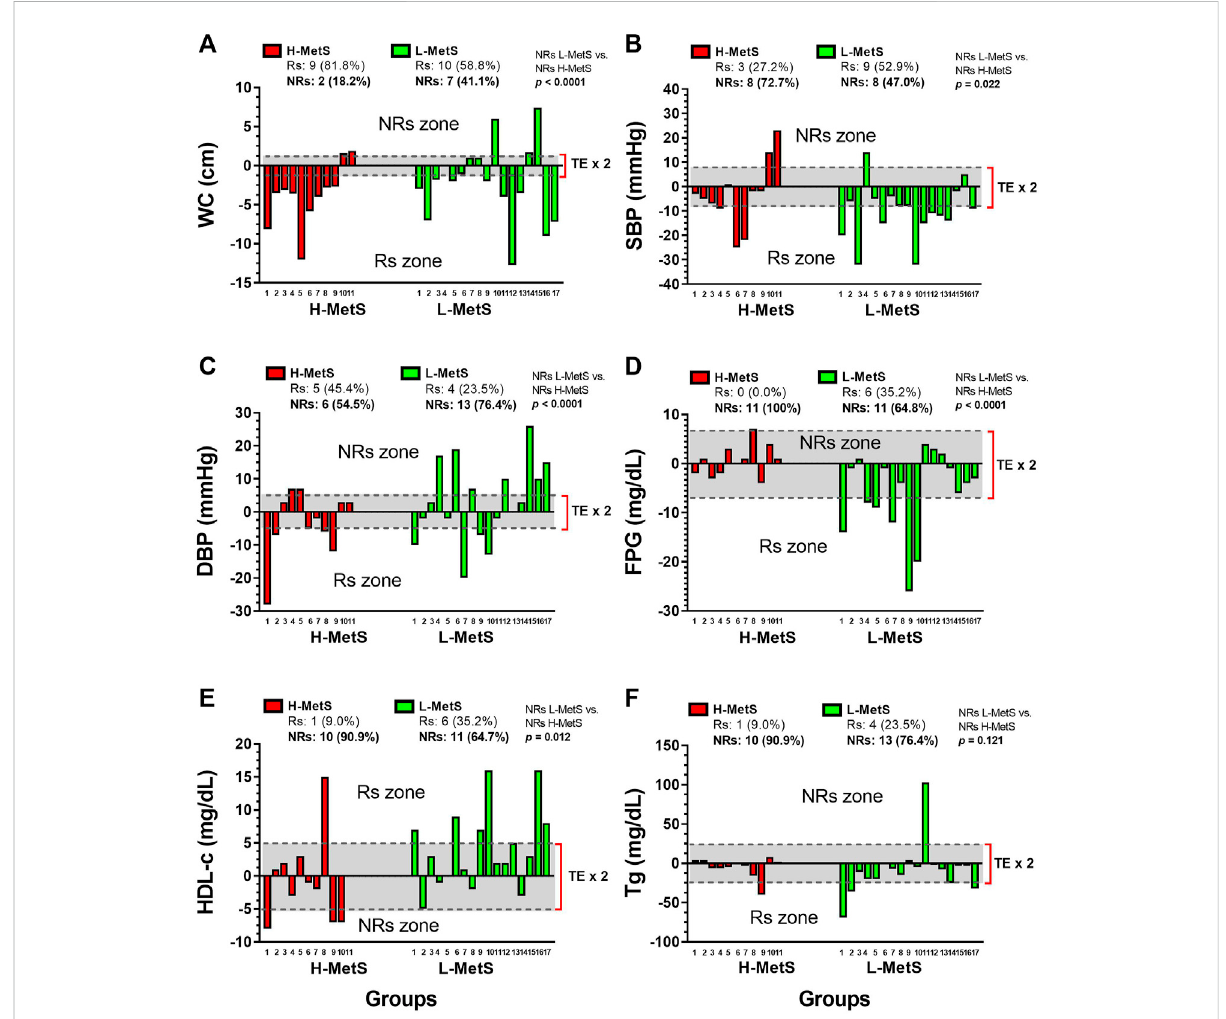
FIGURE 3 Interindividual changes in metabolic syndrome markers between two groups of a different number of risk factors for the metabolic syndrome. Groups are described as H-MetS, high number of metabolic syndrome risk factors group; L-MetS, low number of metabolic syndrome risk factors group; and L-MetS, low number of metabolic syndrome risk factors group at post test. Outcomes are described as WC (panel A ), waist circumference; SBP, systolic blood pressure (panel B ); DBP, diastolic blood pressure (panel C ); FPG, fasting plasma glucose (panel D ); HDL-c, high-density lipoprotein cholesterol (panel E ); Tg, triglycerides (panel F ); Rs, responders; and (NRs) non-responders for improving MetS outcomes. (NRs zone) Denotes all the gray areas in which participants classi fi ed as NRs using the TE parameter. TE, technical error of